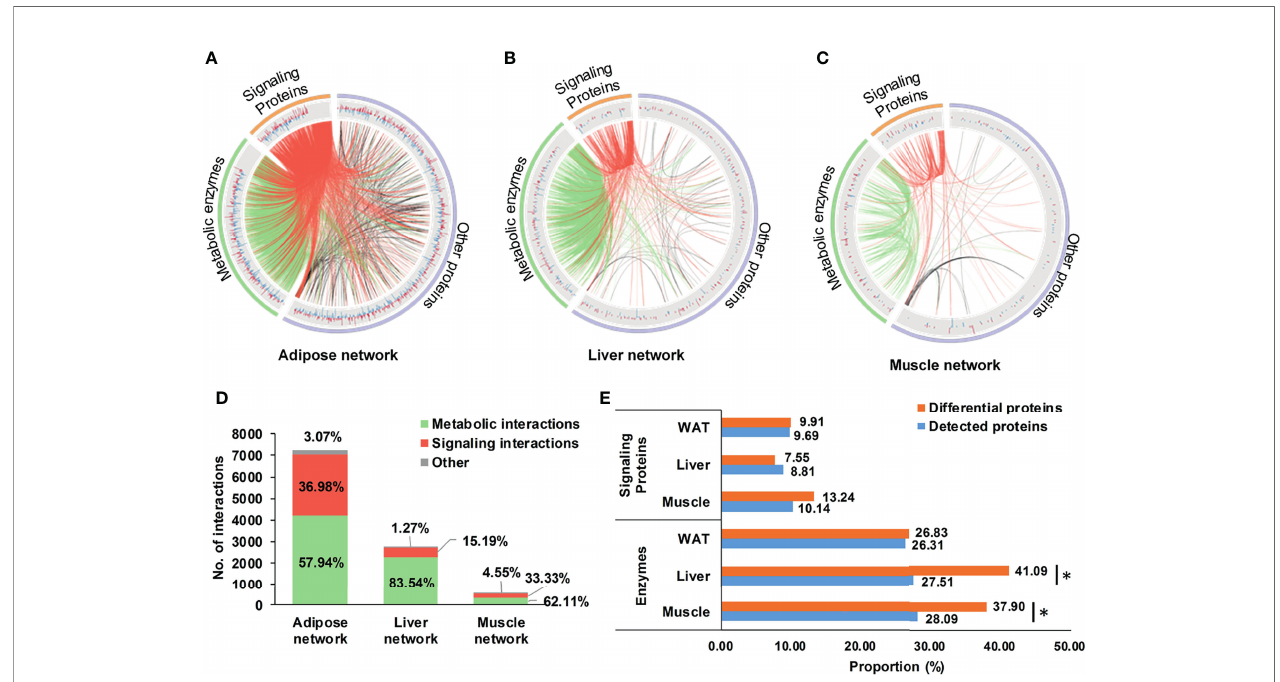
FIGURE 3 | Tissue-speci fi c networks of IR. (A – C) tissue-speci fi c networks of IR. Where, fold changes of all differential proteins were shown in bar plots; signaling protein-related and metabolic enzyme-related interactions were respectively highlighted in red and green; (D) Distribution of metabolic and signaling interactions in tissue-speci fi c networks; (E) Proportion of metabolic enzymes and signaling proteins in differential and detected proteins. *P < 0.05, chi-square